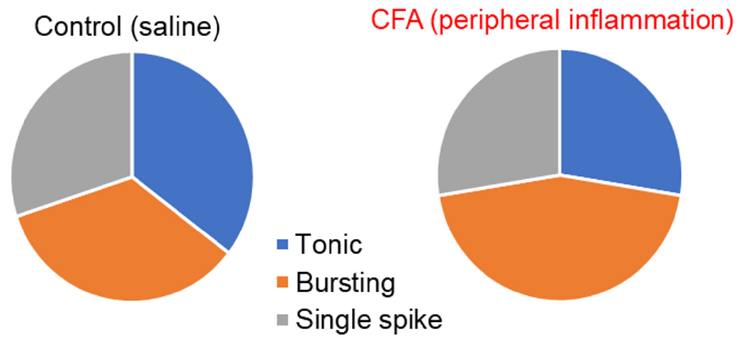
Figure 2. The distribution of neuronal subtypes based on the firing pattern recorded in the superficial DH of the spinal cord in the control (healthy) animals (left) and rats with persistent peripheral inflammation (1-day post-CFA, right). The proportions between the three neuronal classes recorded in the superficial DH did not significantly differ between the control ( left ) and CFA-inflamed ( right ) groups of animals ( p = 0.309, chi − square test).